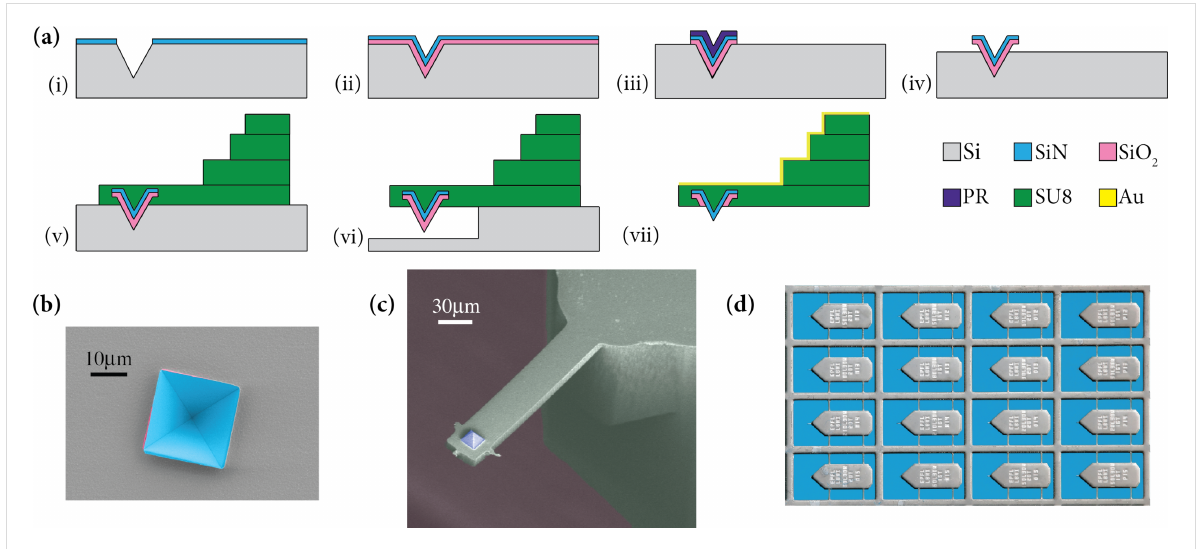
Figure 1: Batch fabrication process of LSNT-tip SU8 cantilevers. (a) Summarized process flow. (b) SEM image of the LSNT and the silicon oxide layers where the silicon underneath has been etched (step iv). (c) SEM image of a single cantilever. The pyramidal tip consists of four